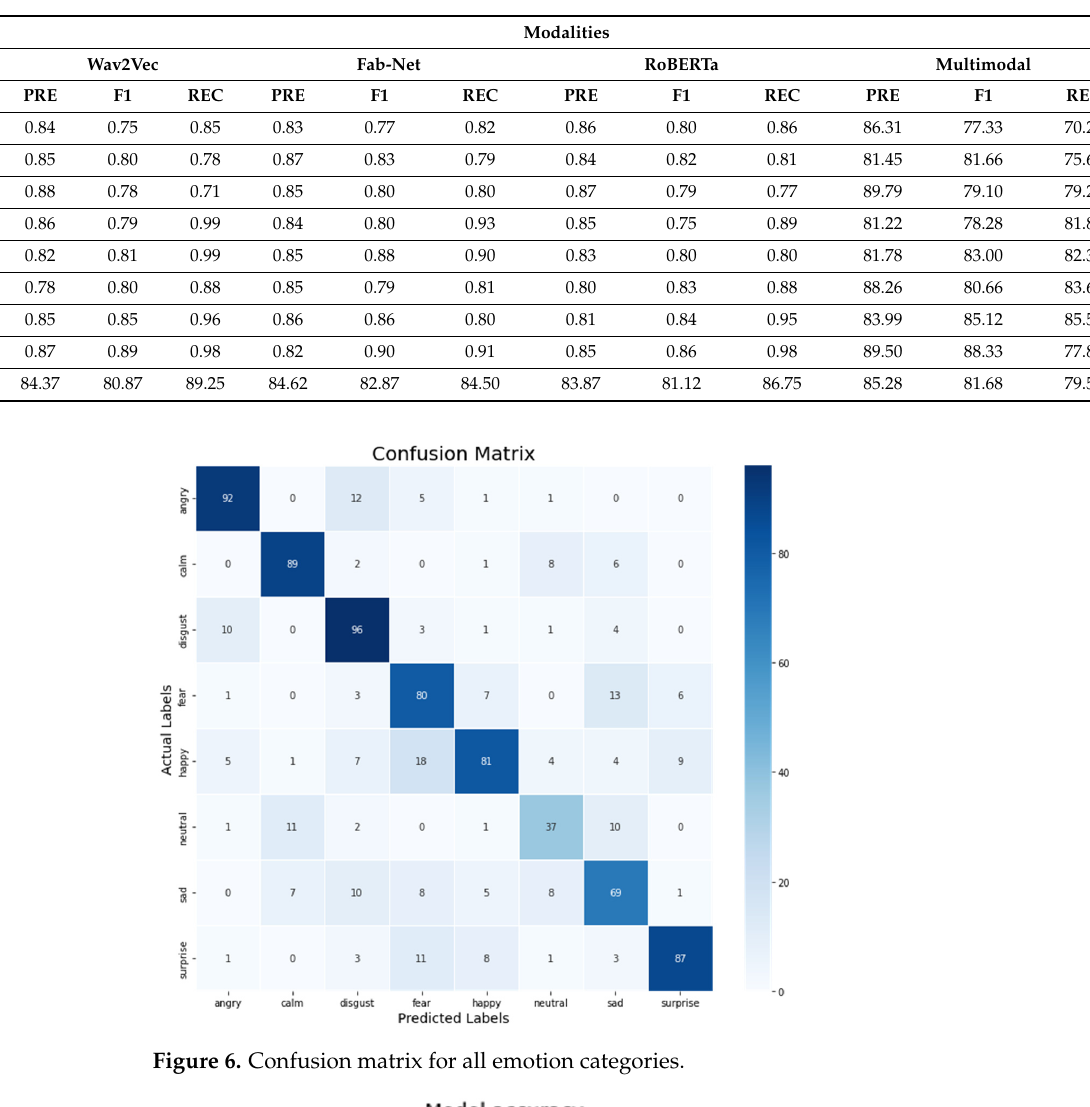
Table 2. Precision, recall, and accuracy metrics per emotion for the top model that achieved an accuracy of 86.40%.